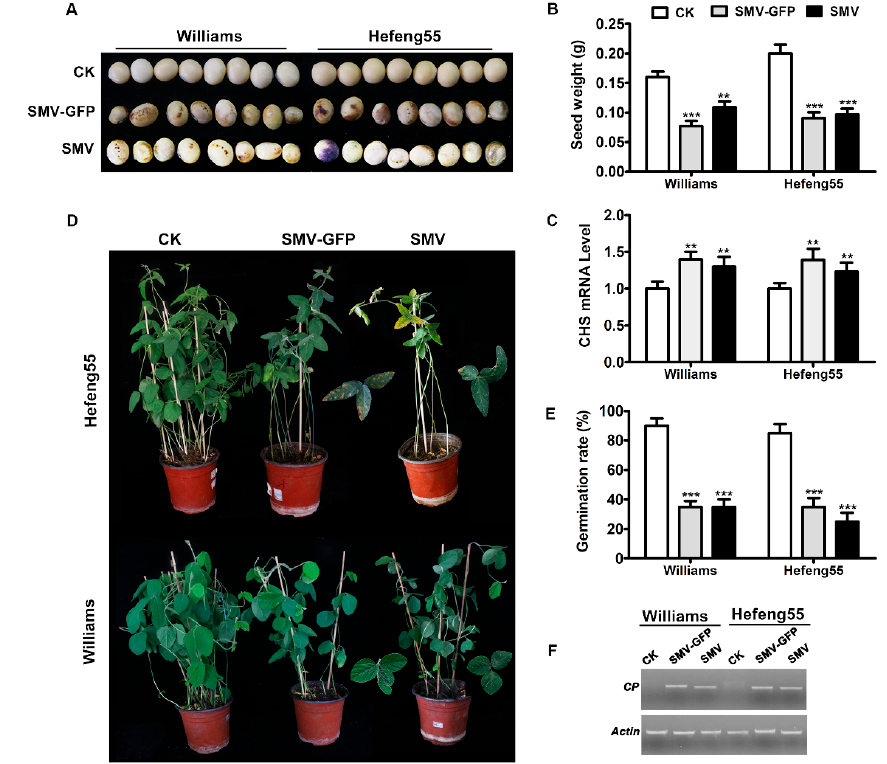
Figure 4. Seed transmission of SMV derived from infectious clones. ( A ) Visual appearance of seed mottling upon infection with SMV derived from infectious clones. ( B ) Weight of the seeds showing mottling upon infection with SMV from infectious clones. T-test was performed between treatment and control group. Double asterisks, p < 0.01, Triple asterisks, p < 0.001. ( C ) CHS mRNA level determined by RT-qPCR assay in mottling seeds. Soybean actin gene expression was used as an internal control. ( D ) Phenotype of SMV-infected progeny seedlings. The mottling seeds were germinated in soil pots, and the phenotype was observed at 35 days. ( E ) Germination assay of SMV-infected seeds. The mottled seeds were germinated in soil pots, and the germination rate was calculated at 20 days. ( F ) SMV-specific RT-PCR analysis of progeny plants from SMV seed transmission. The internal reference gene actin was used as a control. The average number and SE value in each treatment group are shown. Statistical differences between SMV-infected and the control group were evaluated. Double asterisks indicate a significant difference at p < 0.01, and triple asterisks indicate a significant difference at p < 0.001.